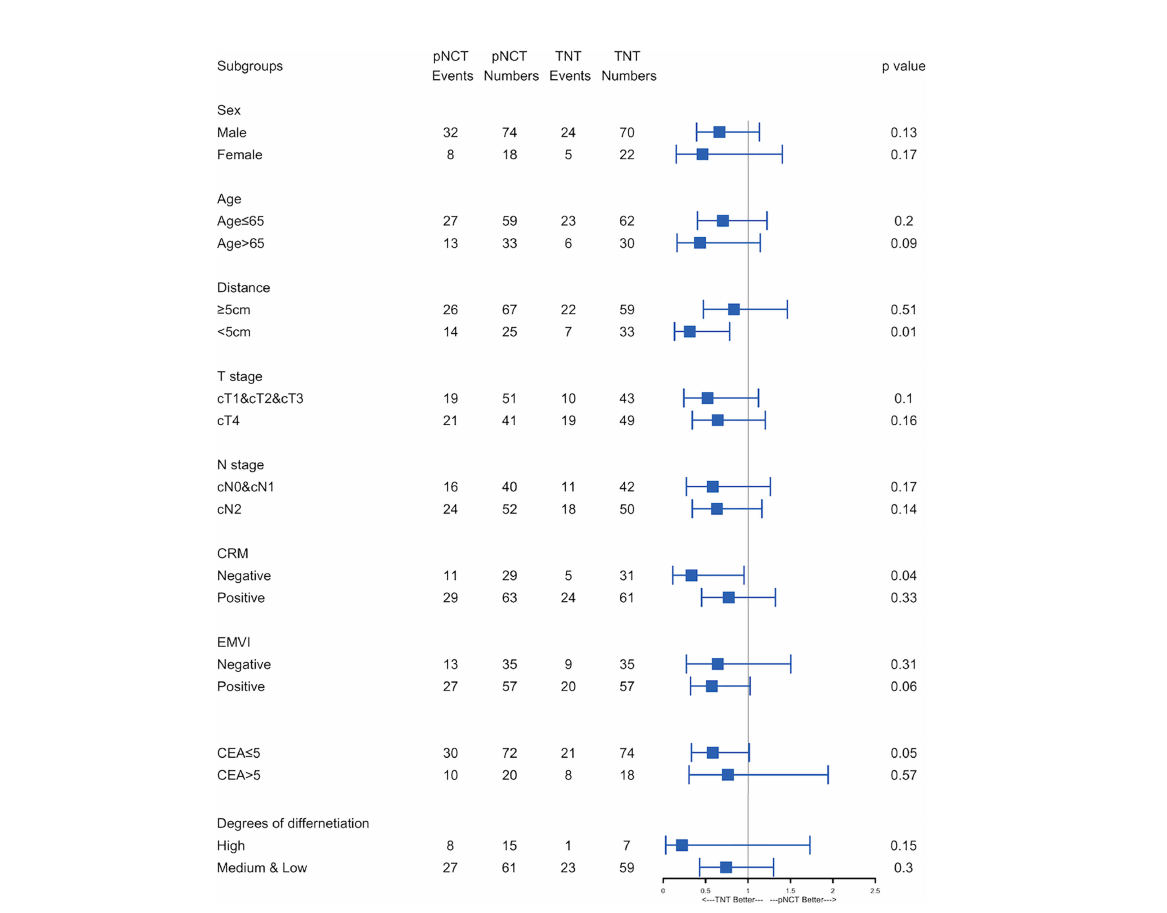
FIGURE 3 Forest plot of recurrence-free survival.Forest plot of recurrence-free survival. Subgroups analyses of recurrence-free survival was performed. pNCT, prolonged neoadjuvant chemotherapy; TNT, total neoadjuvant therapy; CRM, circumference resection margin; EMVI, extramural vascular invasion; ypT, Pathological T stage after neoadjuvant therapy; ypN, Pathological N stage after neoadjuvant therapy; CR, complete response; PR, partial response; SD, stable disease; PD, progressive